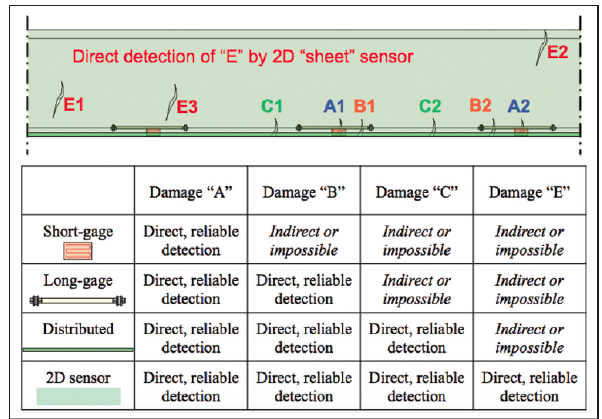
Figure 2. Short-gage, long-gage, distributed, and 2D sensor damage detection capabilities